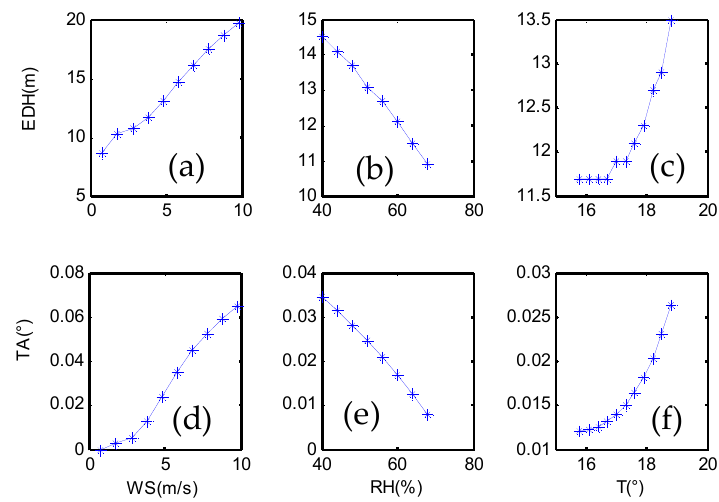
Figure A1. The e ff ects of meteorological parameters on the evaporation ducts: ( a ) height of the Figure A1. The effects of meteorological parameters on the evaporation ducts: (a) height of the evaporation duct (EDH) vs. the wind speed (WS), ( b ) the EDH vs. the relative humidity (RH), evaporation duct (EDH) vs. the wind speed (WS), (b) the EDH vs. the relative humidity (RH), (c) the ( c ) the EDH vs. the temperature (T), ( d ) the trap angle (TA) vs. the wind speed, ( e ) the TA vs. the RH, EDH vs. the temperature (T), (d) the trap angle (TA) vs. the wind speed, (e) the TA vs. the RH, and and ( f ) the TA vs. the (f) the TA vs. the temperature.